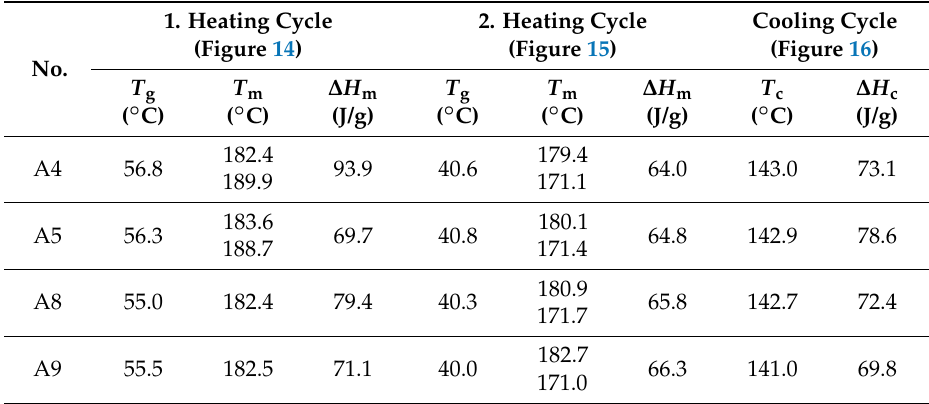
Table 8. Results of DSC